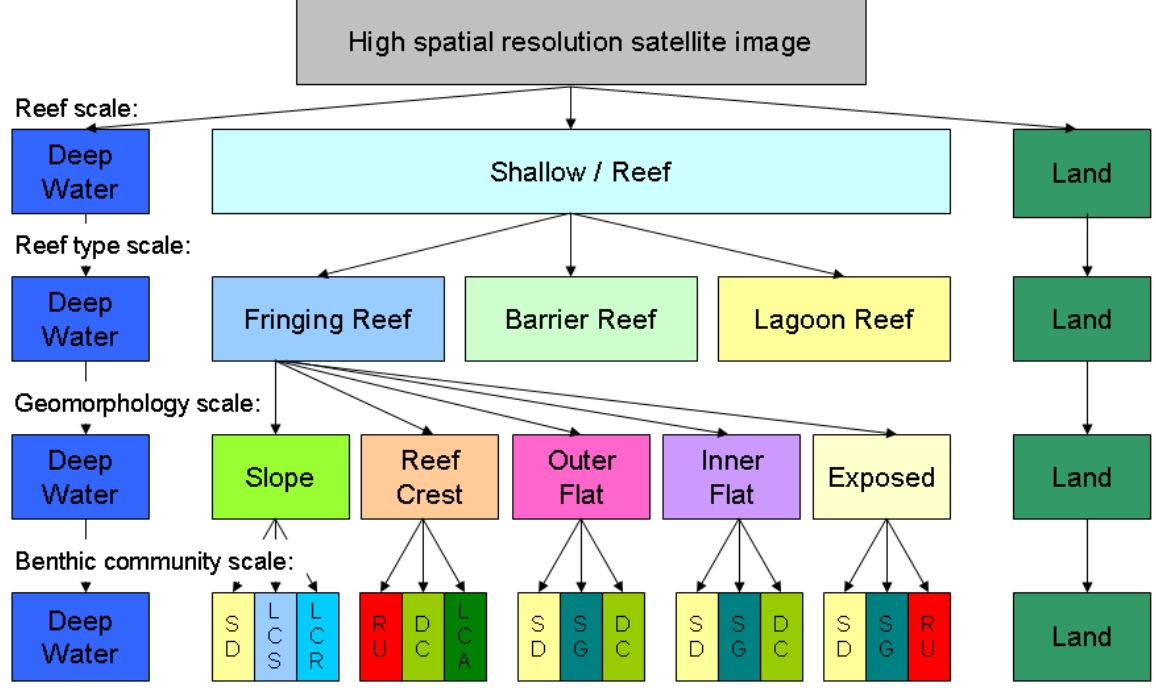
Figure 3. Example of a hierarchical class structure diagram of mapping categories at four different spatial scales: reef, reef type, geomorphology zone, and benthic community. For clarity, only a limited range of example classes at the geomorphology and benthic community scales are shown, and only for the fringing reef type. Abbreviations at the benthic community scale are: SD = sand, LCS = live coral and sand, LCR = live coral and rock, RU = rubble, DC = dead coral, LCA = live coral and algae, SG =